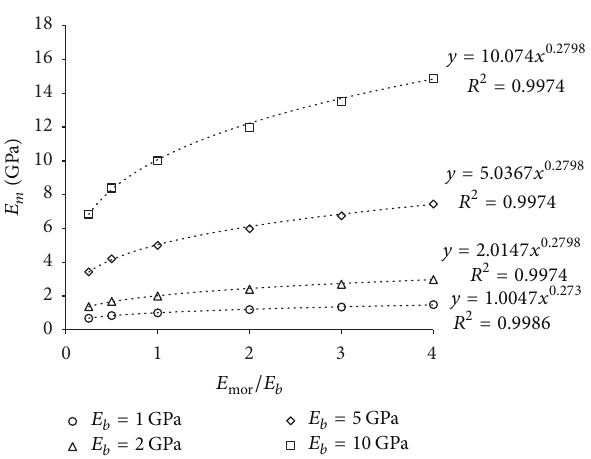
Figure 5: Simulation results of equivalent elastic moduli of brick